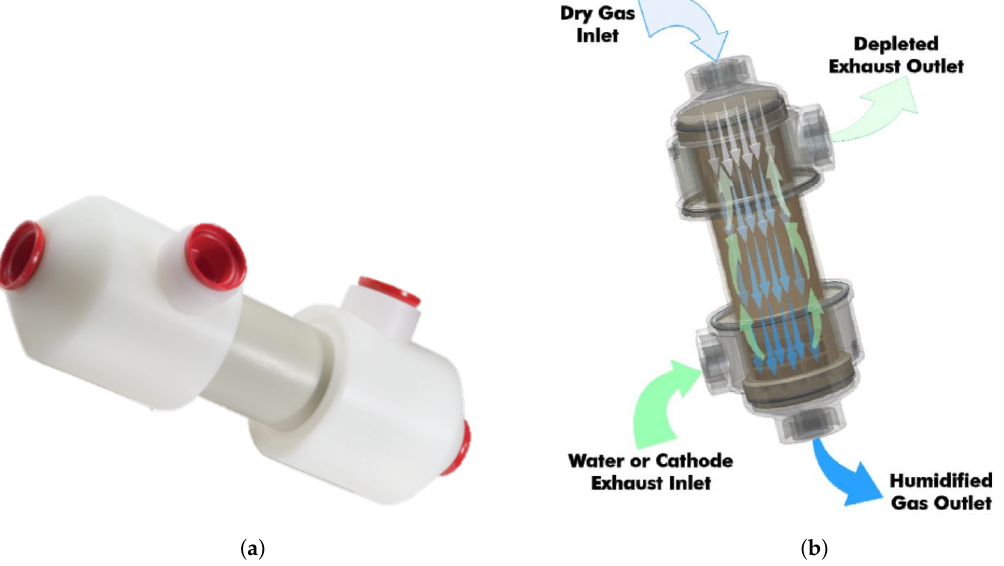
Figure 1. ( a ) Nafion Tubing component before installation in the NTHS [23] ( b ) and a schematic view of its working principle.